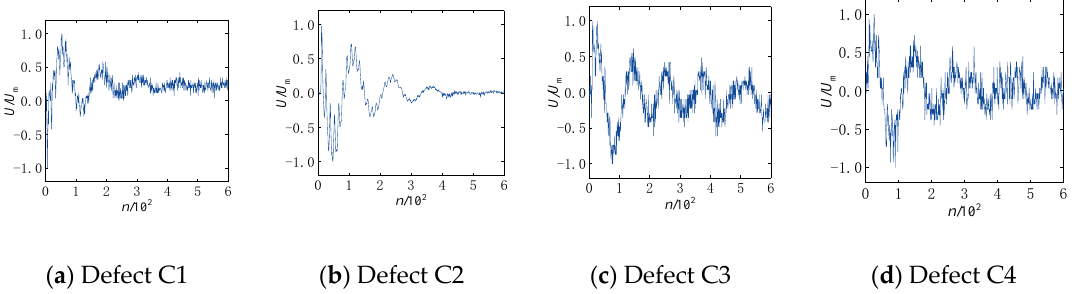
Figure 5. Preprocessed discharge pulse of four defects.